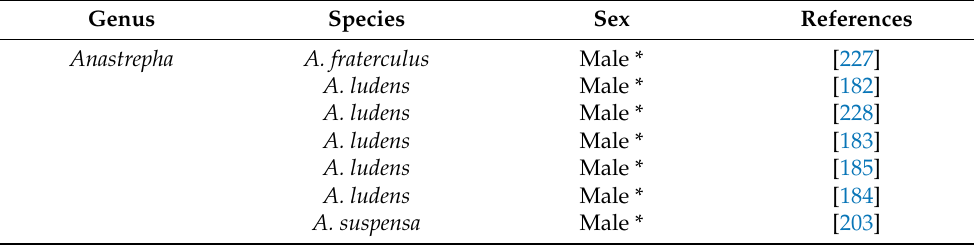
Table 2. List of tephritid species for which pheromones have been derived from rectal glands extracts.